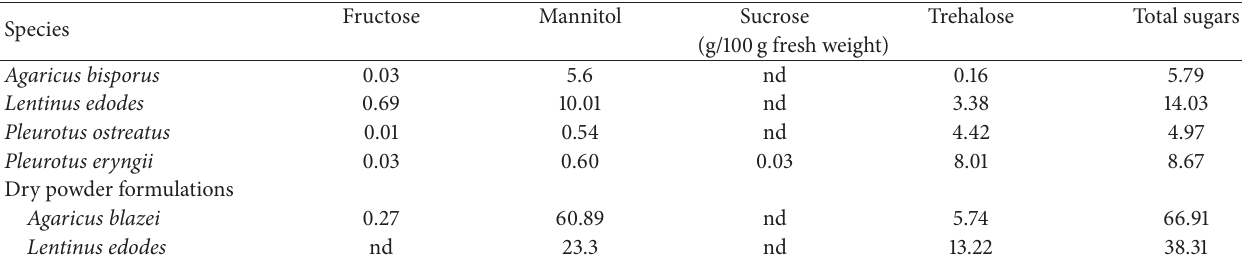
Table 2: Composition of sugars of some edible mushrooms (dry